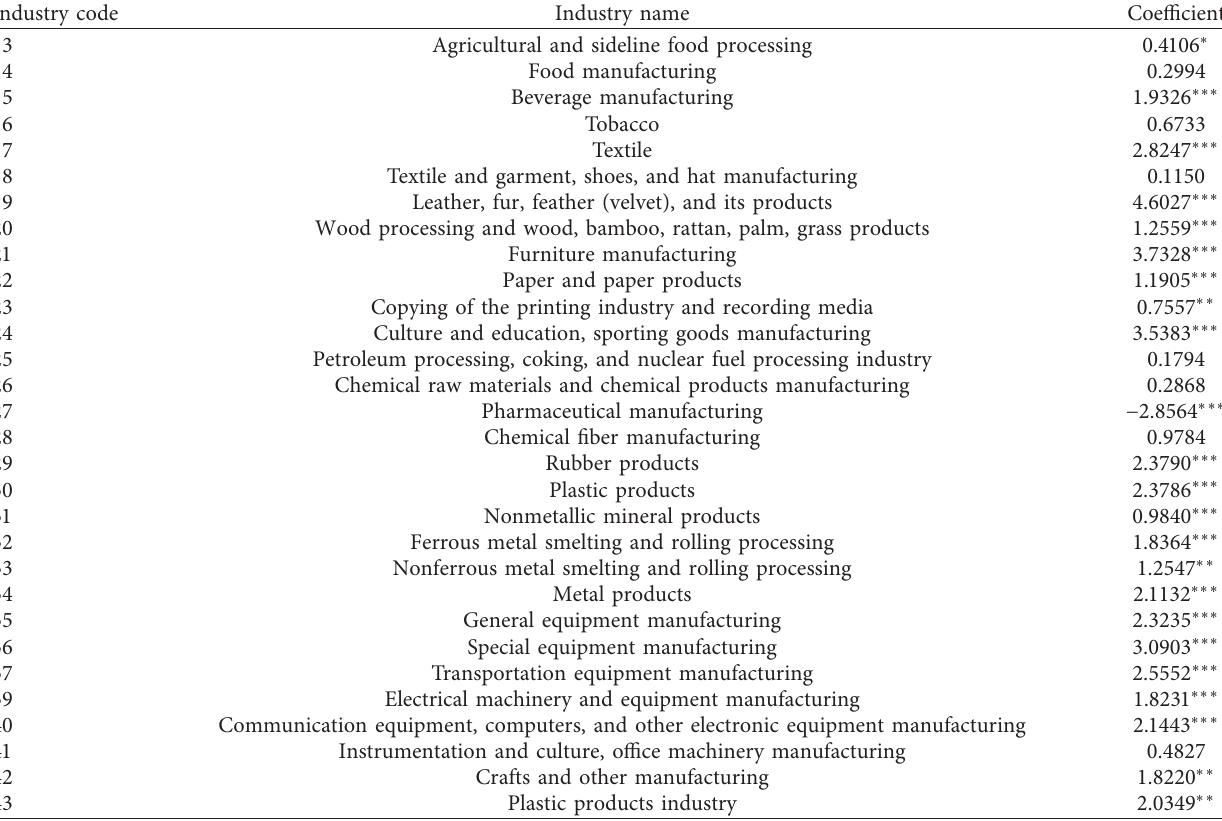
Table 12: Coefficient of all industry regression